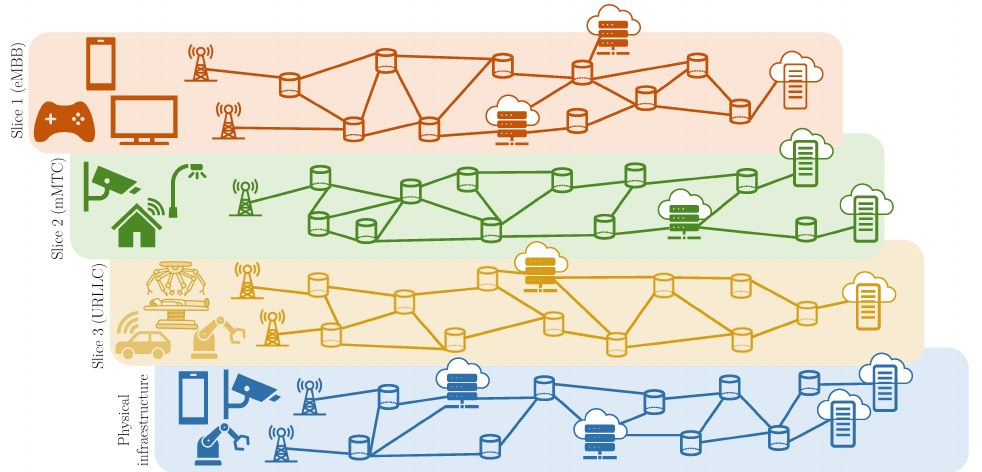
Figure 1. 5G network slicing architecture.